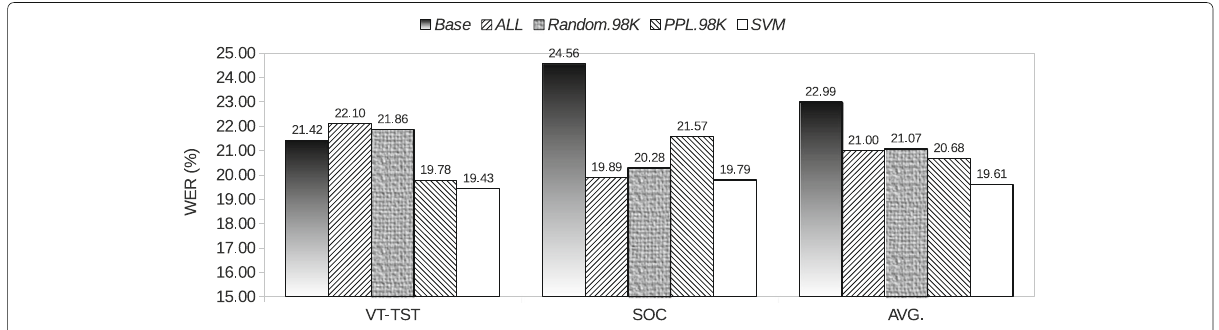
Fig. 7 Recognition performance (WER) using 98K selected